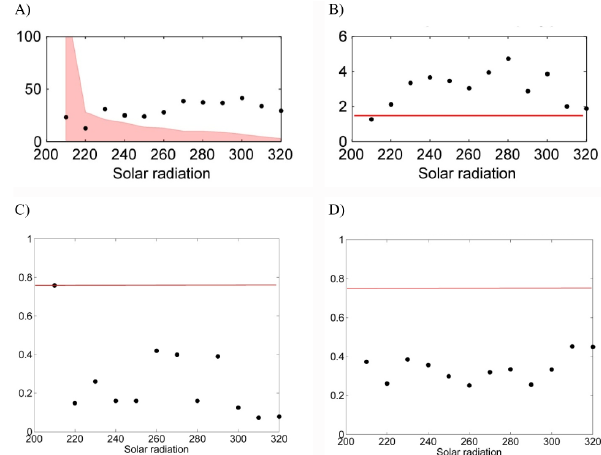
Fig. 11. Statistical analysis of the vegetation clusters for the fields of vegetation obtained by varying annual precipitation. (A) Mean size of clusters and range 0.025–0.975 quantile of the mean cluster size corresponding to a binomial process with the same percent- age cover. (B) Mean ratio between the span in the x-direction and the span in the y-direction of each cluster; red line represents the boundary between spots and bands. (C) Percentage of the domain filled by the largest cluster; red line represents the minimum fraction of area filled for the field to be considered labyrinthine. (D) Fraction of area of the largest cluster filled by vegetation; red line represents the maximum fraction of the largest cluster that can be filled for the field to be considered labyrinthine.